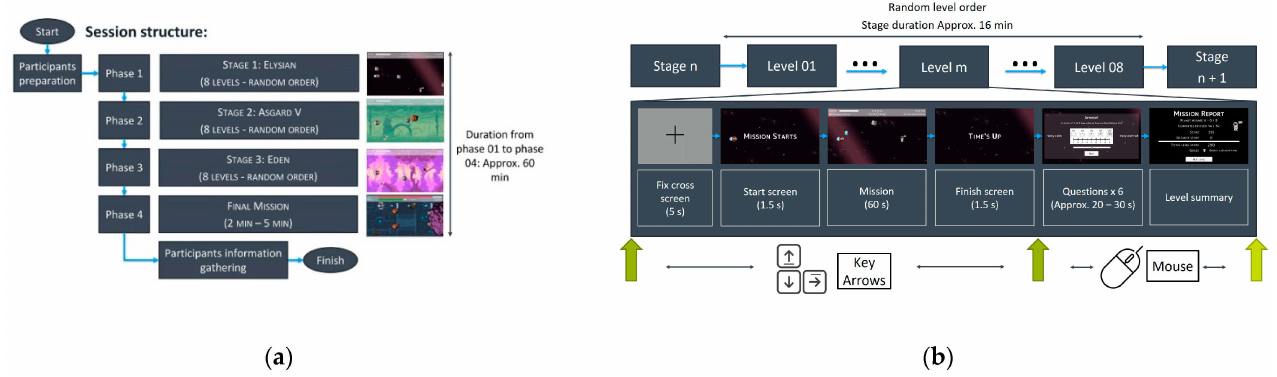
Figure 1. Game structure for one experiment session and level structure: ( a ) game structure composed by 3 phases containing the 3 designed stages; ( b ) game level’s